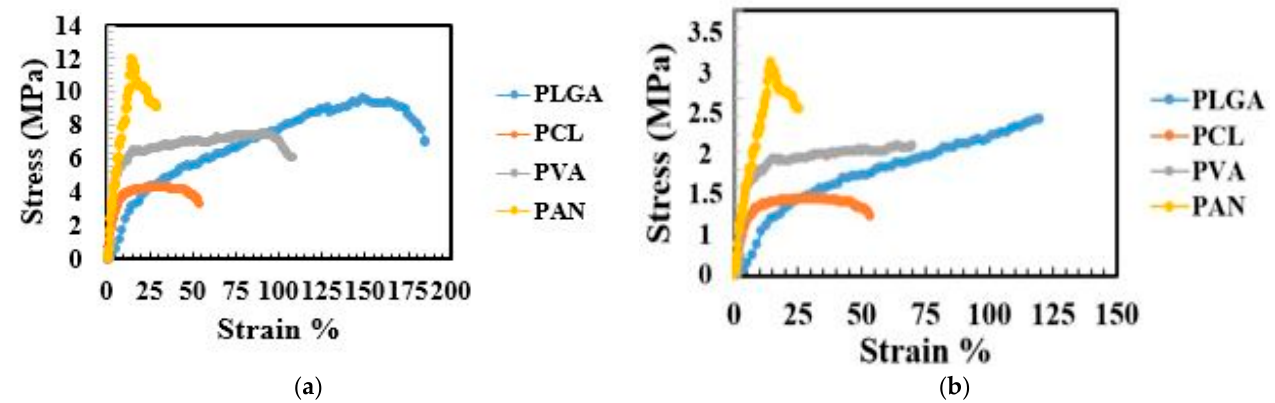
Figure 4. Stress-strain curves of cylindrical nanofibrous structures, ( a ) with ‘aligned’ fibers, ( b ) with ‘not aligned’ fibers.